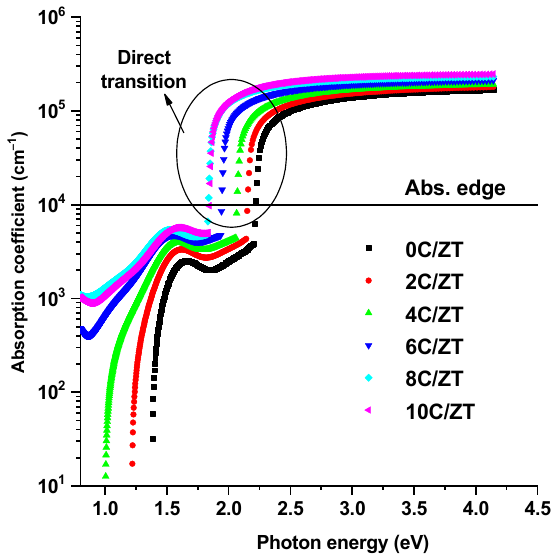
Figure 9. The absorption coefficient versus photon energy of the ZnTe:Cu films. The results show that the absorption increases with an increase in the Cu content. It can also be observed that when the degree of Cu incorporation increases, the absorption value drops at the absorption edge and shifts to a lower energy. Using Tauc’s model [42], the optical band gap energy of the Cu-doped films is determined from the following equa- tion: